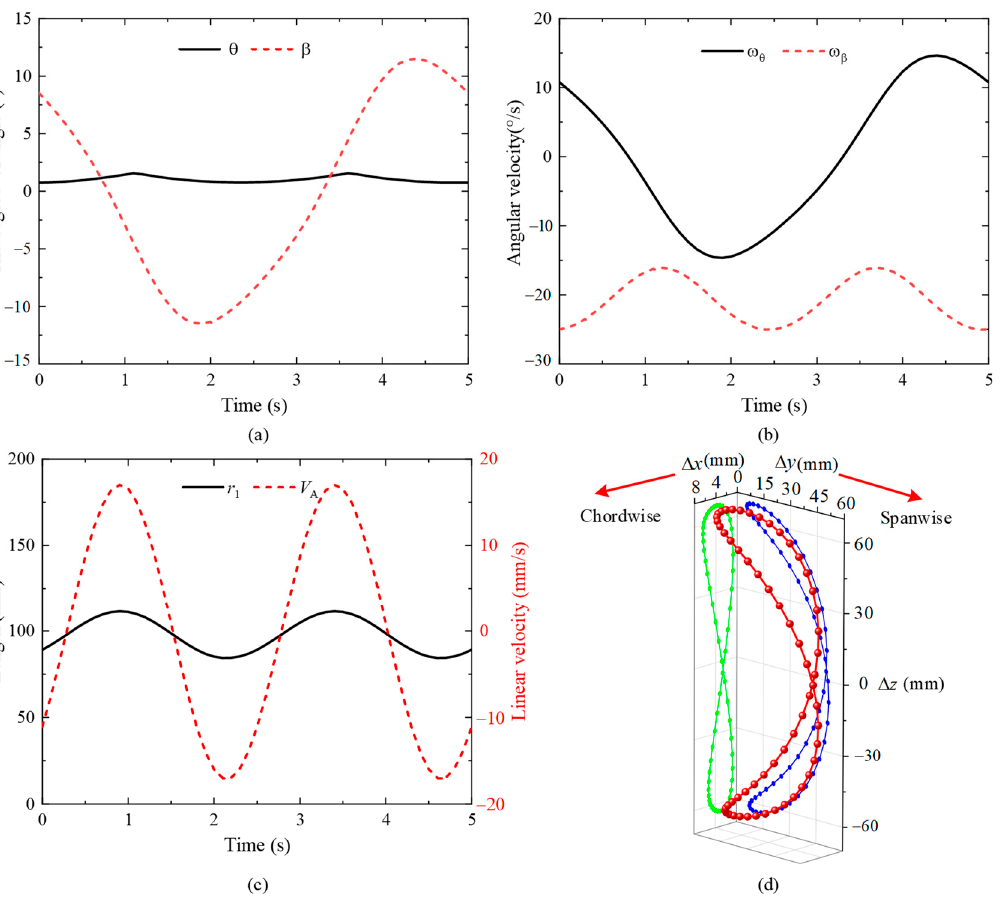
Figure 4. Motion analysis results of the bionic pectoral fin. ( a ) The curves of θ and β changes over time. ( b ) The curves of ω θ and ω β changes over time. ( c ) The curves of r 1 and V A changes over time. ( d ) The spatial trajectories of the left pectoral fin coordinate origin o l changes over time.